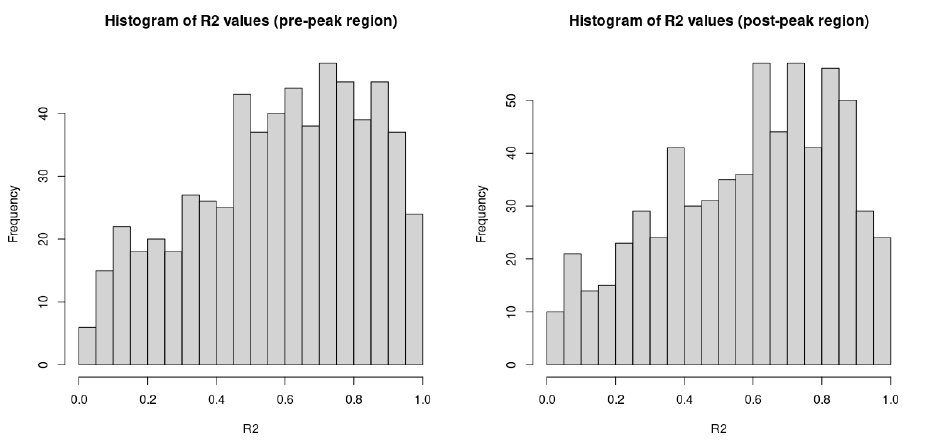
Figure A2. Histograms for the r-squared values of the models fitted to the pre-peak region ( left ) and the post-peak region ( right ), with a window size of 20